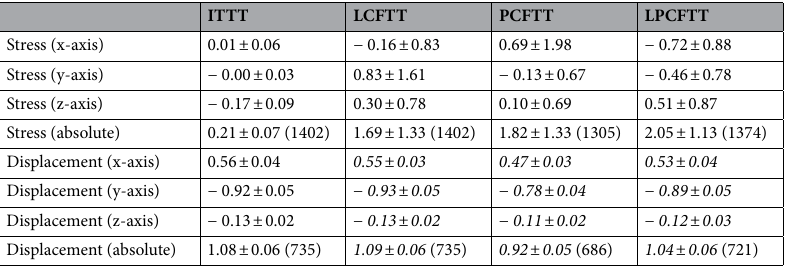
Table 2. Von Mises stress and displacement of TT between ITTT and fracture models with TT. The content inside parentheses was the number of extracted nodes or elements. Data were expressed as mean ± standard deviation. The values of the fracture models with TT were compared with those of ITTT. P < 0.05 and the better results of each fracture models are indicated as italics.